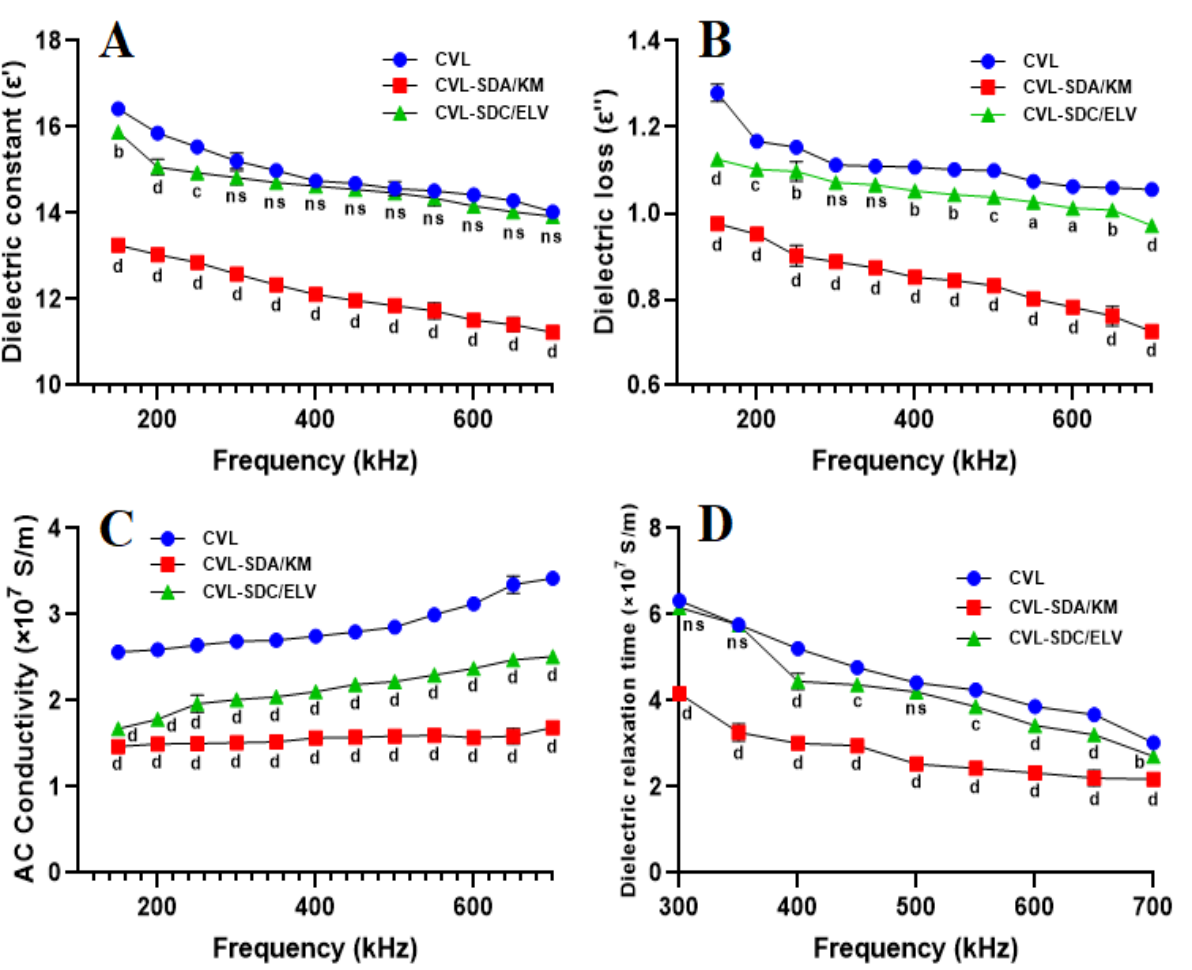
Figure 9. Dielectric analysis of the ( A ) dielectric constant, ( B ) dielectric loss, ( C ) AC conductivity, and ( D ) dielectric relaxation time (data expressed as mean ± SD, n = 3; ns: non-significant, a: p < 0.05, b: p < 0.01, c: p < 0.001, d: p < 0.0001, with respect to the control group (CVL).